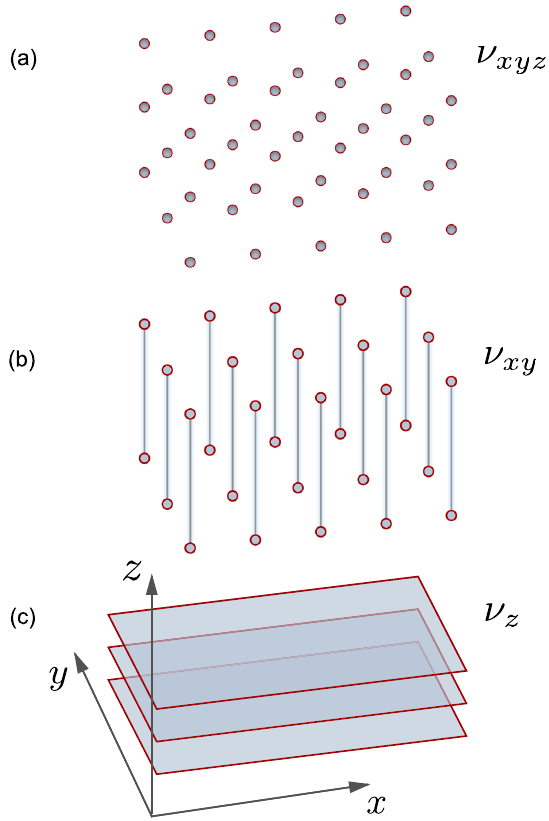
FIG. 2. The types of 3D weak SPT phases. (a) Filling 0D SPT phases (charge density), ν (c) Stacking 2D SPT phases, ν